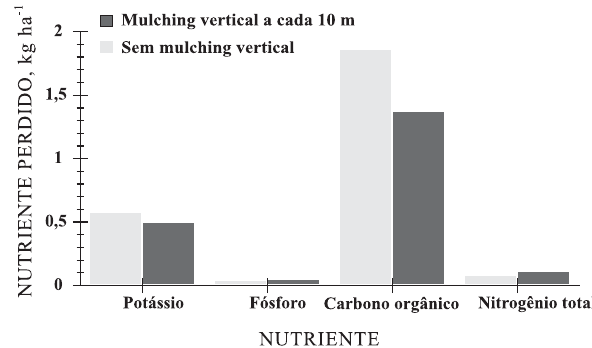
Figura 5. Perda de nutrientes e de carbono orgânico no escoamento superficial, obtida com chuva simulada com intensidade de 106 mm h -1 , em Latossolo Vermelho distrófico típico, durante o ciclo da cultura da soja, em semeadura direta, nos tratamentos sem vertical mulching e vertical mulching a cada 10